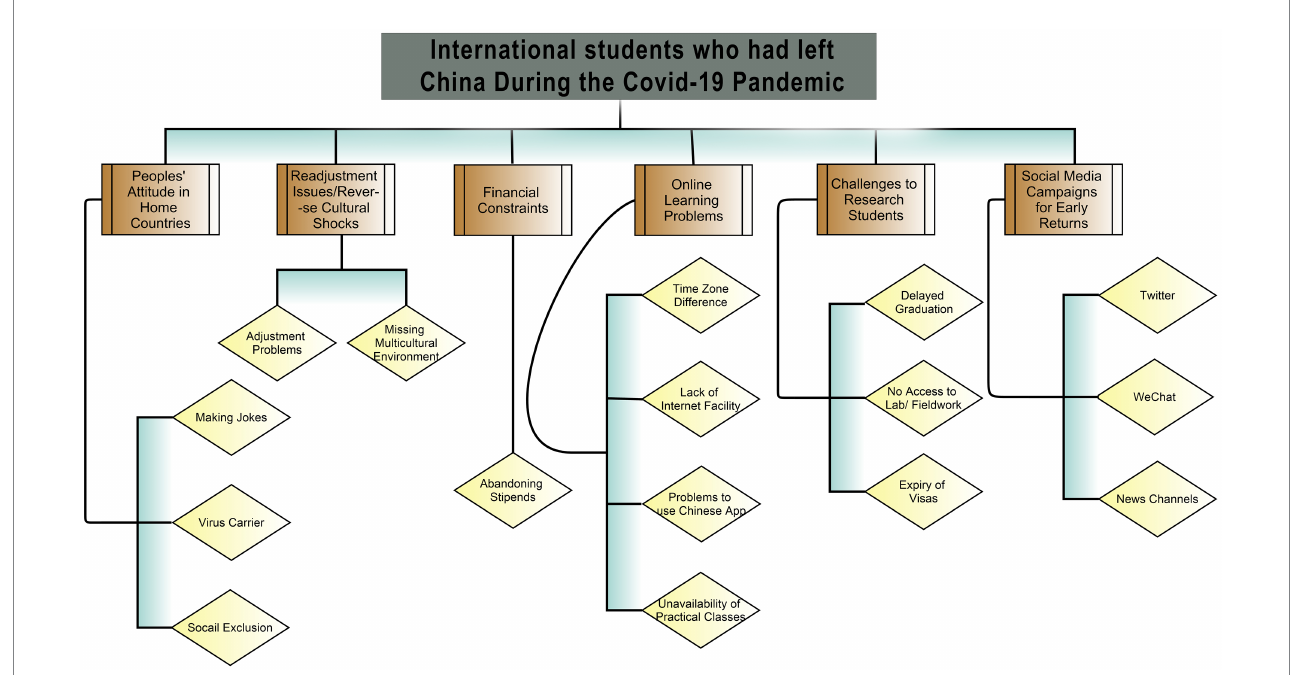
FIGURE 2 Schematize representation of themes regarding International students who had left China during the pandemic and stranded in their home